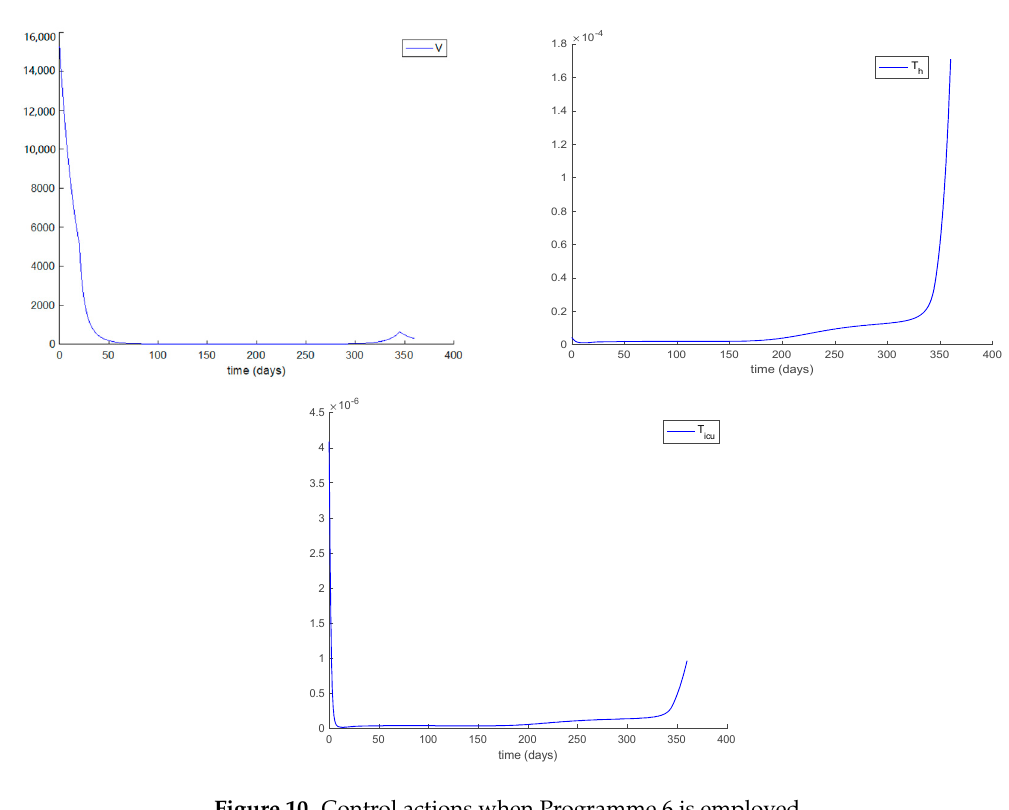
Figure 9. Control gains when Programme 6 is employed.